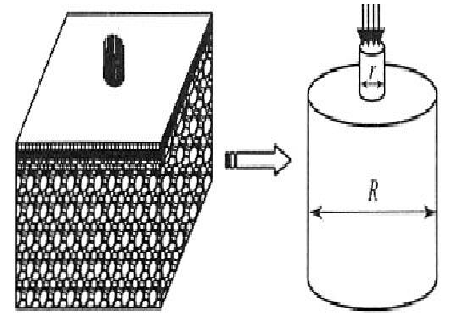
Figure 4 . Test model diagram. Figure 4. Test model diagram.